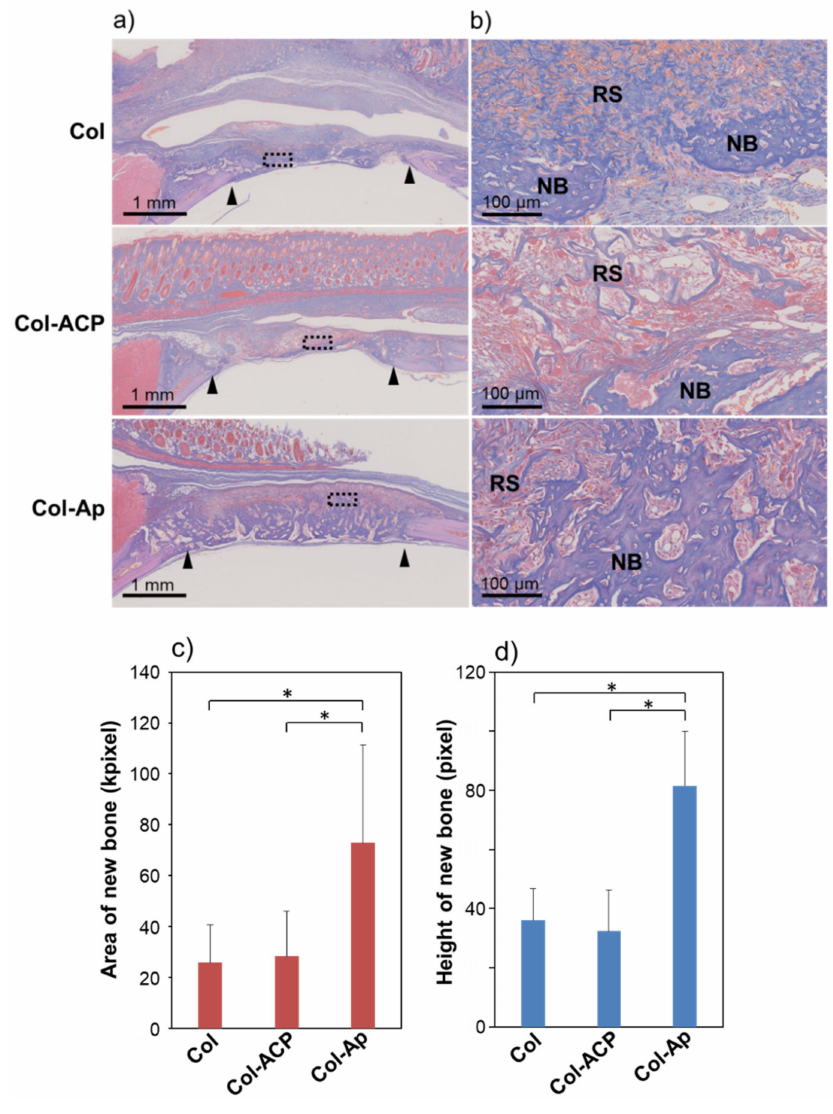
Figure 4. ( a ) Optical microscopic images of the histological sections of the rat cranial bone two weeks after implantation of Col (top row), Col-ACP (middle row), and Col-Ap (bottom row); ( b ) Magnified images of the square region (dashed line squares) in ( a ). ( c ) Area and ( d ) height of the newly formed bone tissue from quantitative analyses of the histological sections (mean + standard deviation, n = 6, * p < 0.05). Black arrowheads in ( a ) indicate the border of the initially created bone defect. NB and RS in ( b ) indicate newly formed bone tissue and residual scaffold,